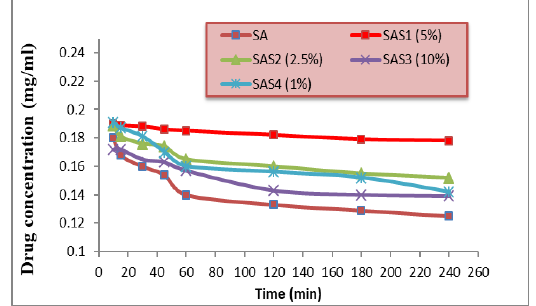
Figure 2. Apparent concentration-time profile of supersaturable nebivolol-loaded SNA with a different amount of soluplus in 0.1N HCl. Morphological visualization by Transmission Electron Microscope (TEM)